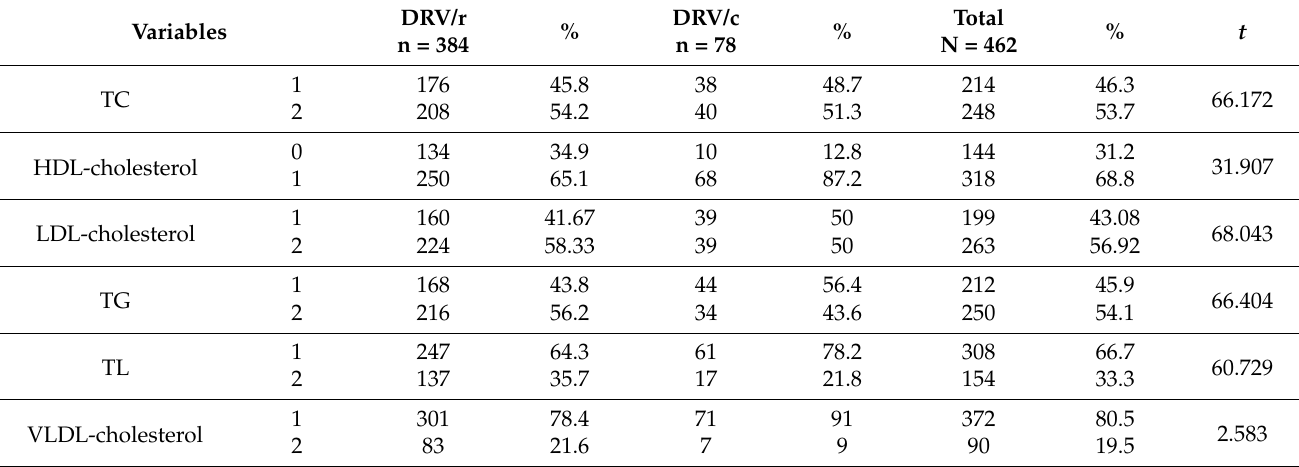
Table 3. Descriptive statistics of lipid profile parameters ( p < 0.01).